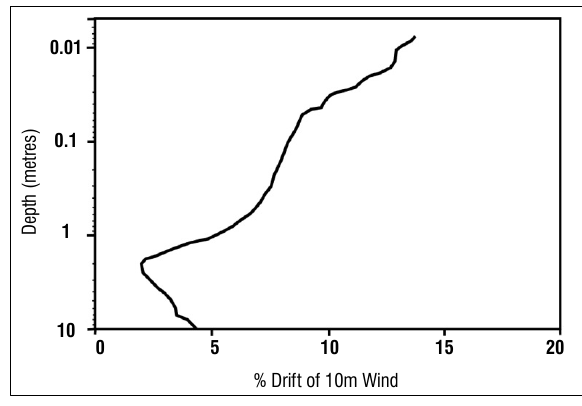
Figure 2: Wind and wave drift profile in the upper 10 m with a wind speed of 4.3 m/s and waves with a wave period of 1.9 s and significant wave height of 0.86 m (adapted from Laxague et al. 24 ). Note the logarithmic depth